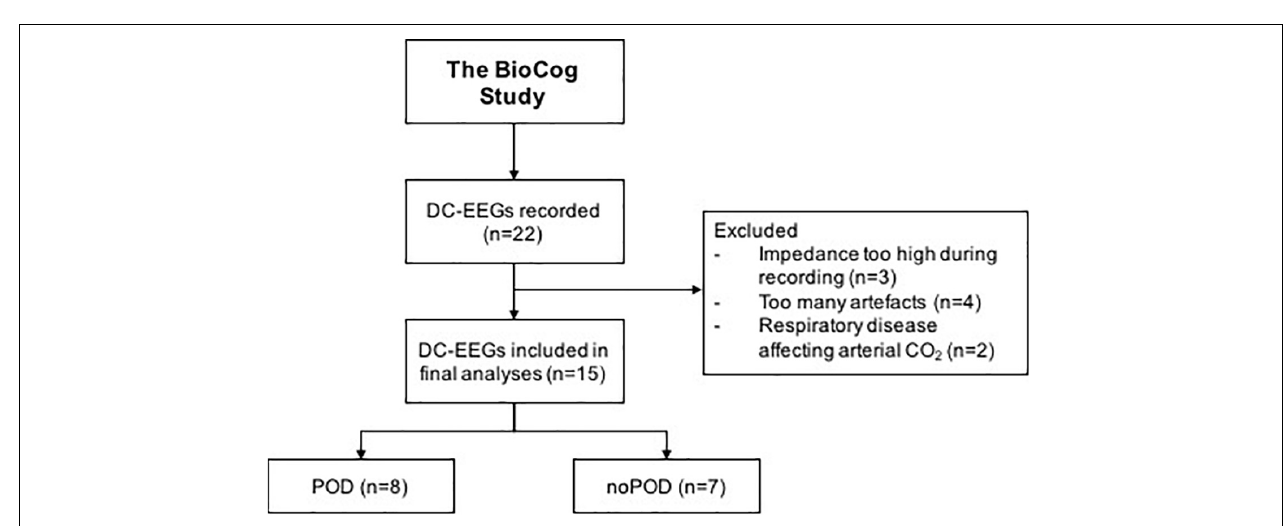
FIGURE 2 | Consort